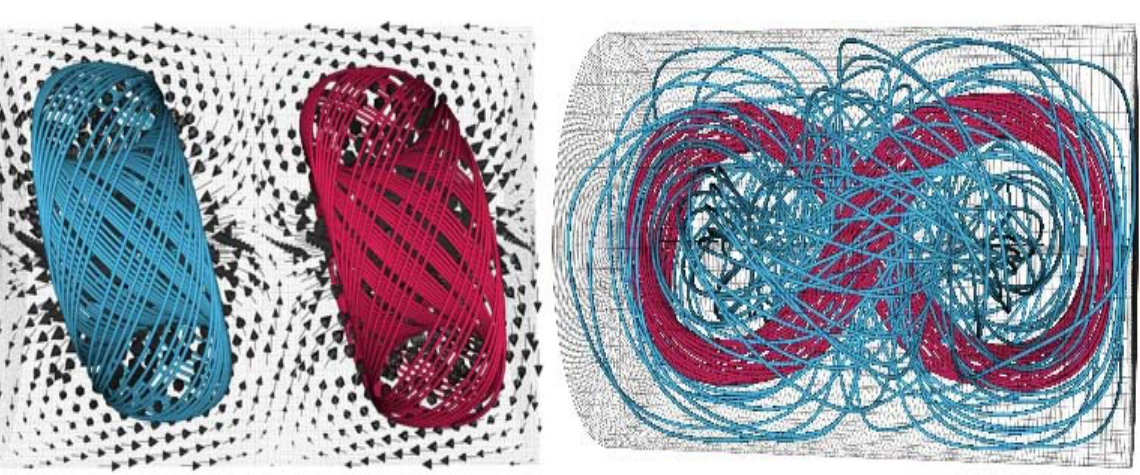
Figure 18. HiFi simulation of two interacting 3D magnetic structures, called spheromaks. Shown are streamlines of magnetic field as the two spheromaks tilt and reconnect through a localized region containing a magnetic null (left panel), merging into a single helical structure (right panel). Magnetic field vectors in the φ = ± π /2 plane are shown in the left panel. Successful comparison of the simulation with the SSX experimental data has been performed